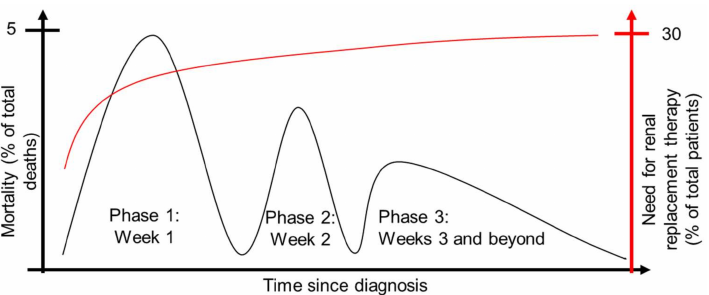
Figure 1. Sepsis mortality is triphasic, with three major peaks of mortality (black). The need for renal replacement therapy increases rapidly during phase 1 and only gradually thereafter (red). Based on data from